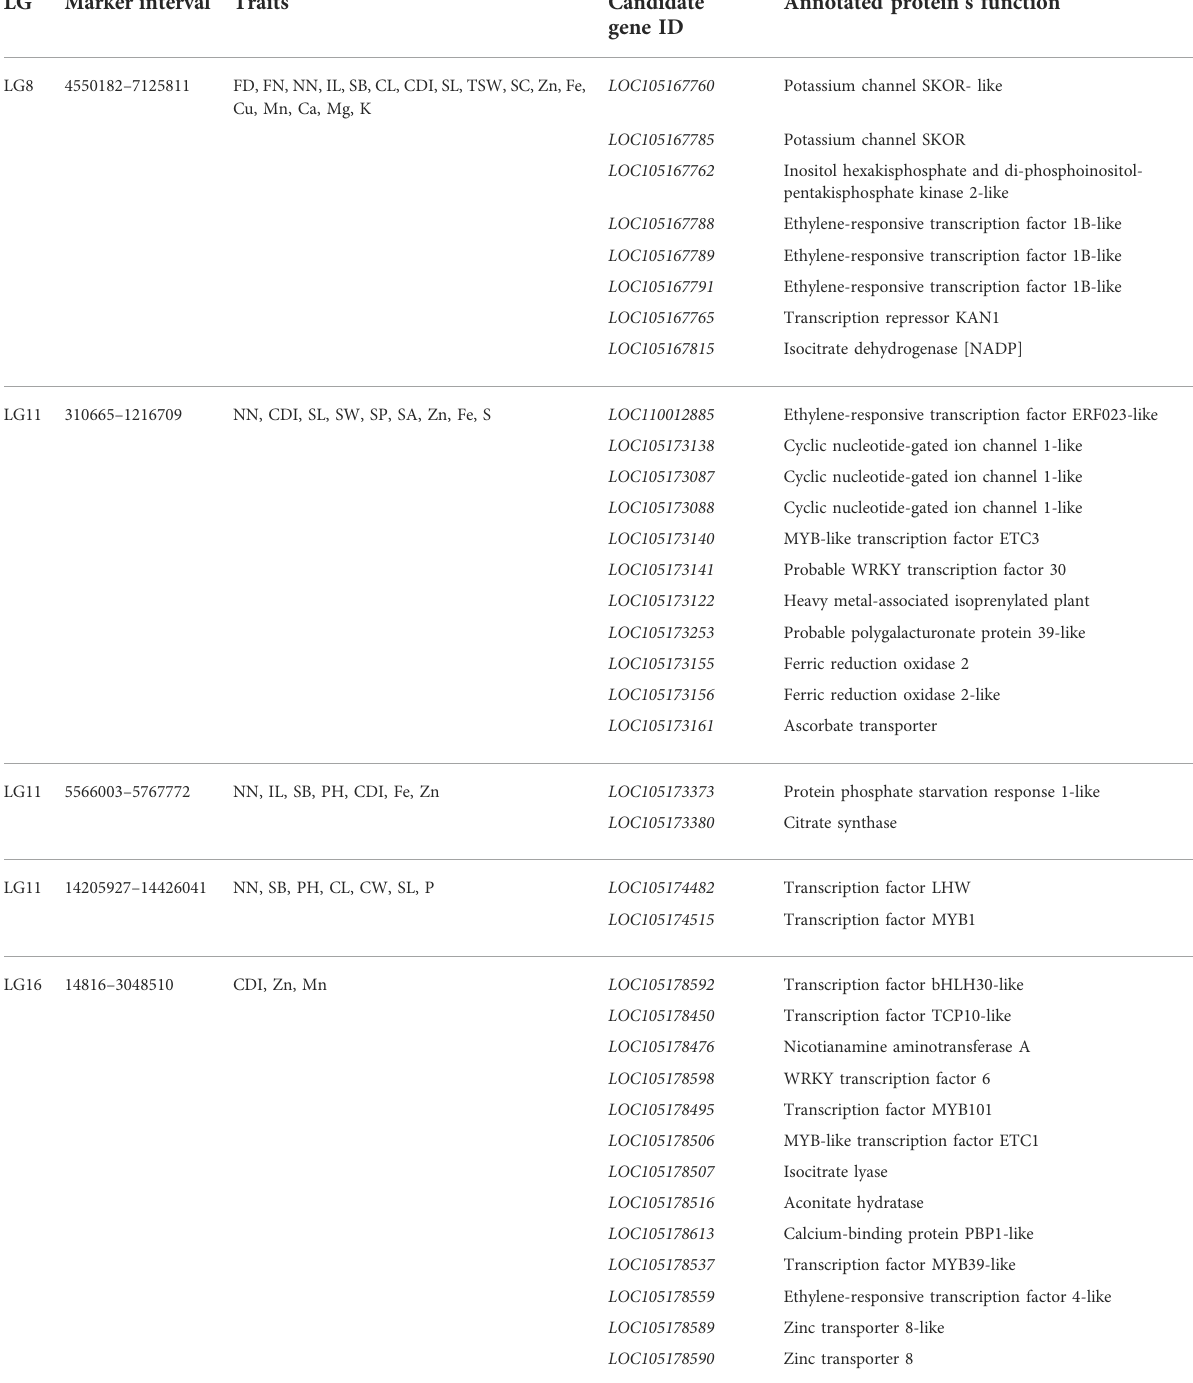
TABLE 12 Candidate genes and their protein annotation for mineral nutrients.